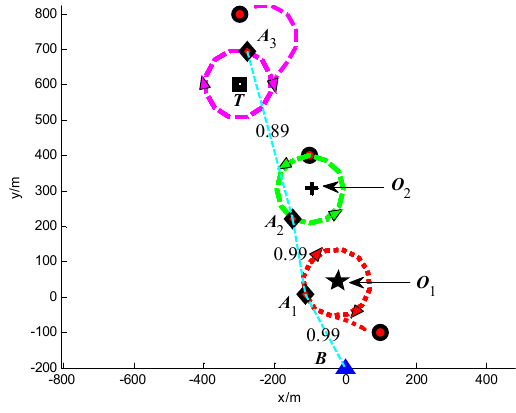
Figure 34. Trajectories of UAVs at t = 100 s (Scenario 4).